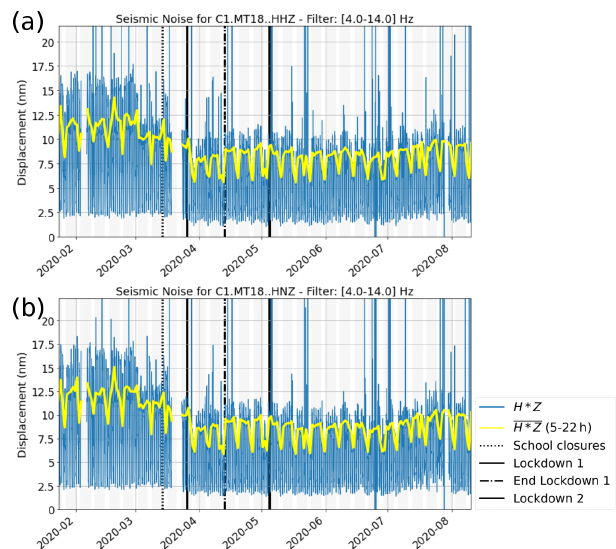
Figure 3. Comparison between (a) broadband and (b) strong- motion seismic noise amplitudes for station MT18 in downtown Santiago. The blue line corresponds to the rms amplitude time series of the vertical component, filtered between 4–14Hz, and the yel- low line corresponds to median daytime amplitude between 05:00– 22:00LT. Gaps correspond to periods for which seismic data are unavailable. The vertical black lines indicate the time of public re- strictions implemented in Santiago. The grey and white background corresponds to weekdays and weekends, respectively. The key leg- end H ∗ Z can be applied for broadband (HHZ) and strong-motion (HNZ) seismic